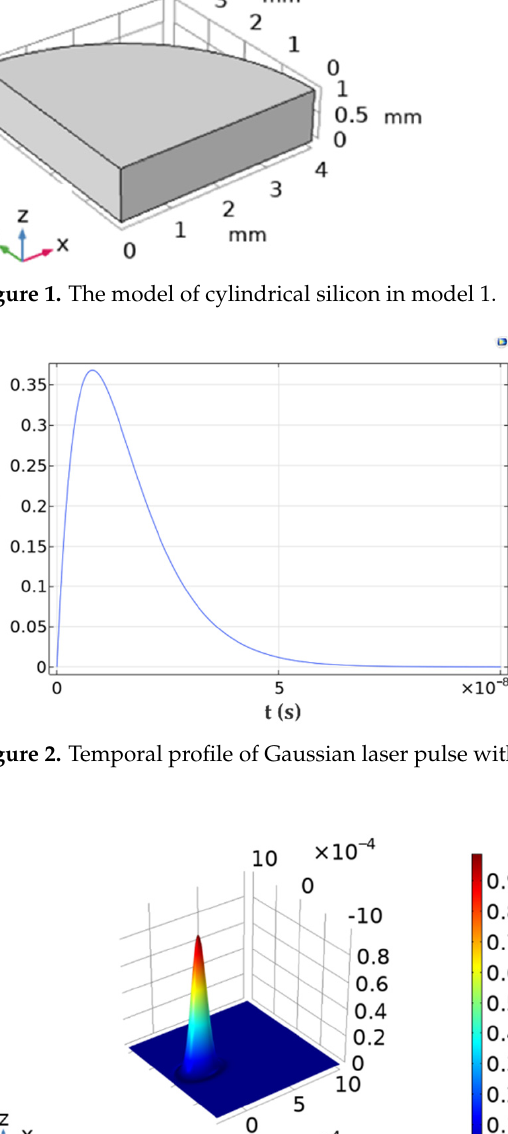
Figure 3. Gaussian laser pulse space profile with r 0 = 100 µm.